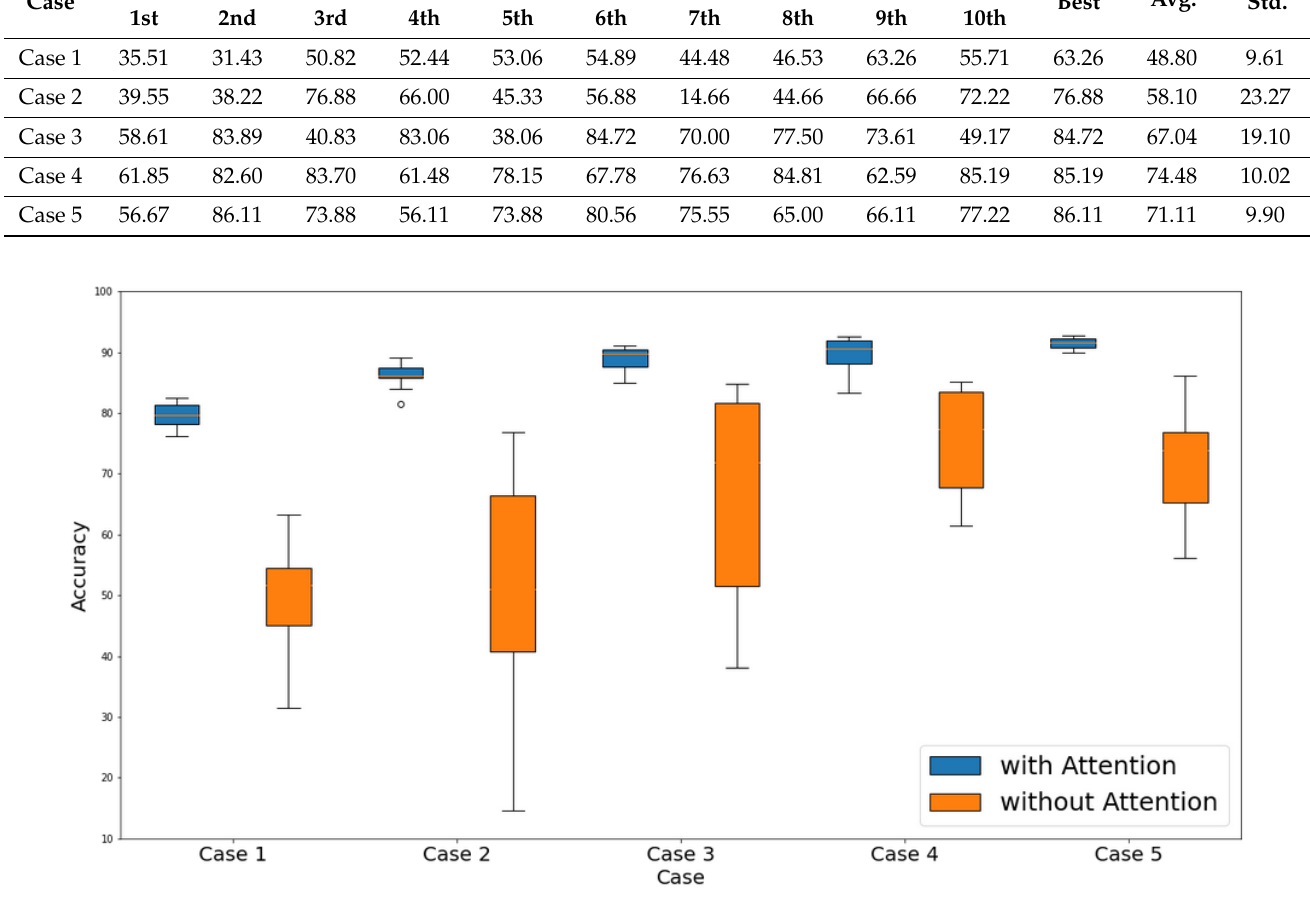
Figure 11. Boxplot of the accuracy distribution with and without attention layer.